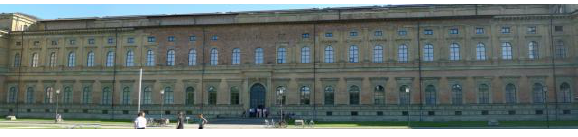
Figure 9. Northern façade of the Old Pinakothek